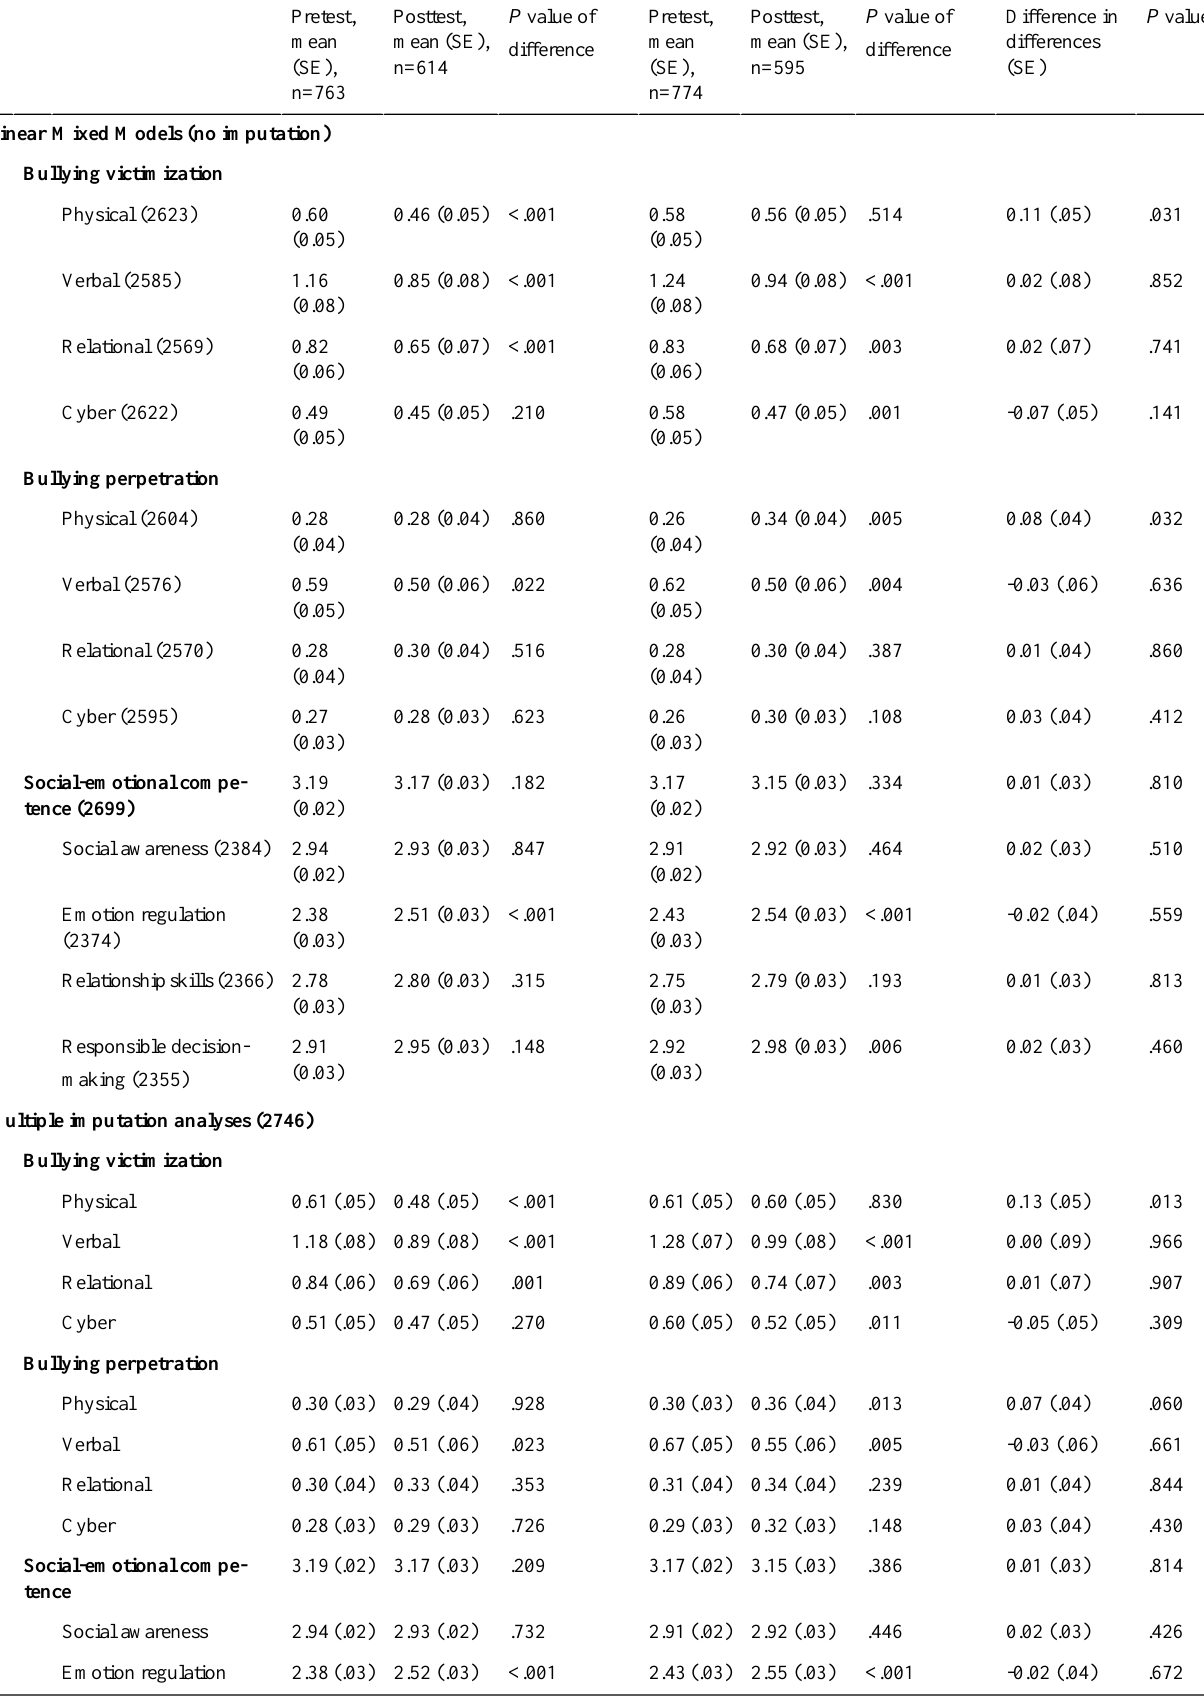
Table 2. Intention-to-treat study outcomes with standard errors. InteractionInterventionControlVariable (#